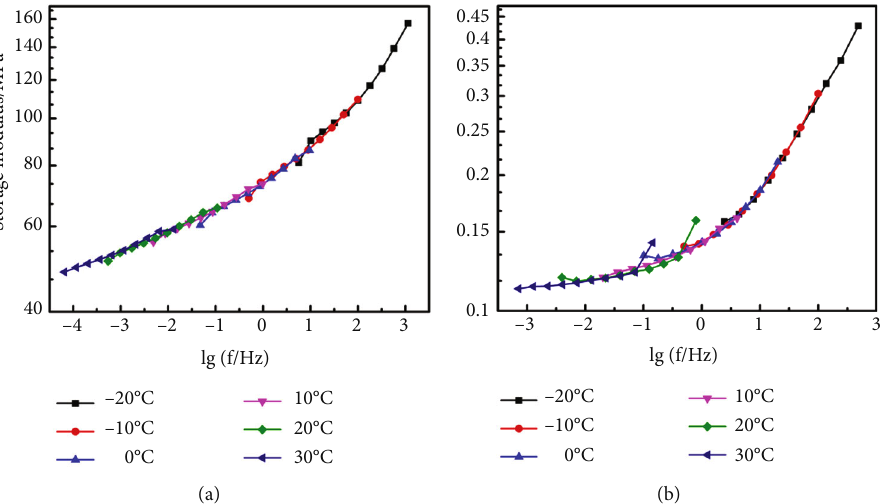
Figure 4: (a) Master curve of storage modulus changing with logarithm of frequency at − 10 ° C. (b) Master curve of loss tangent changing with logarithm of frequency at − 10 ° C.